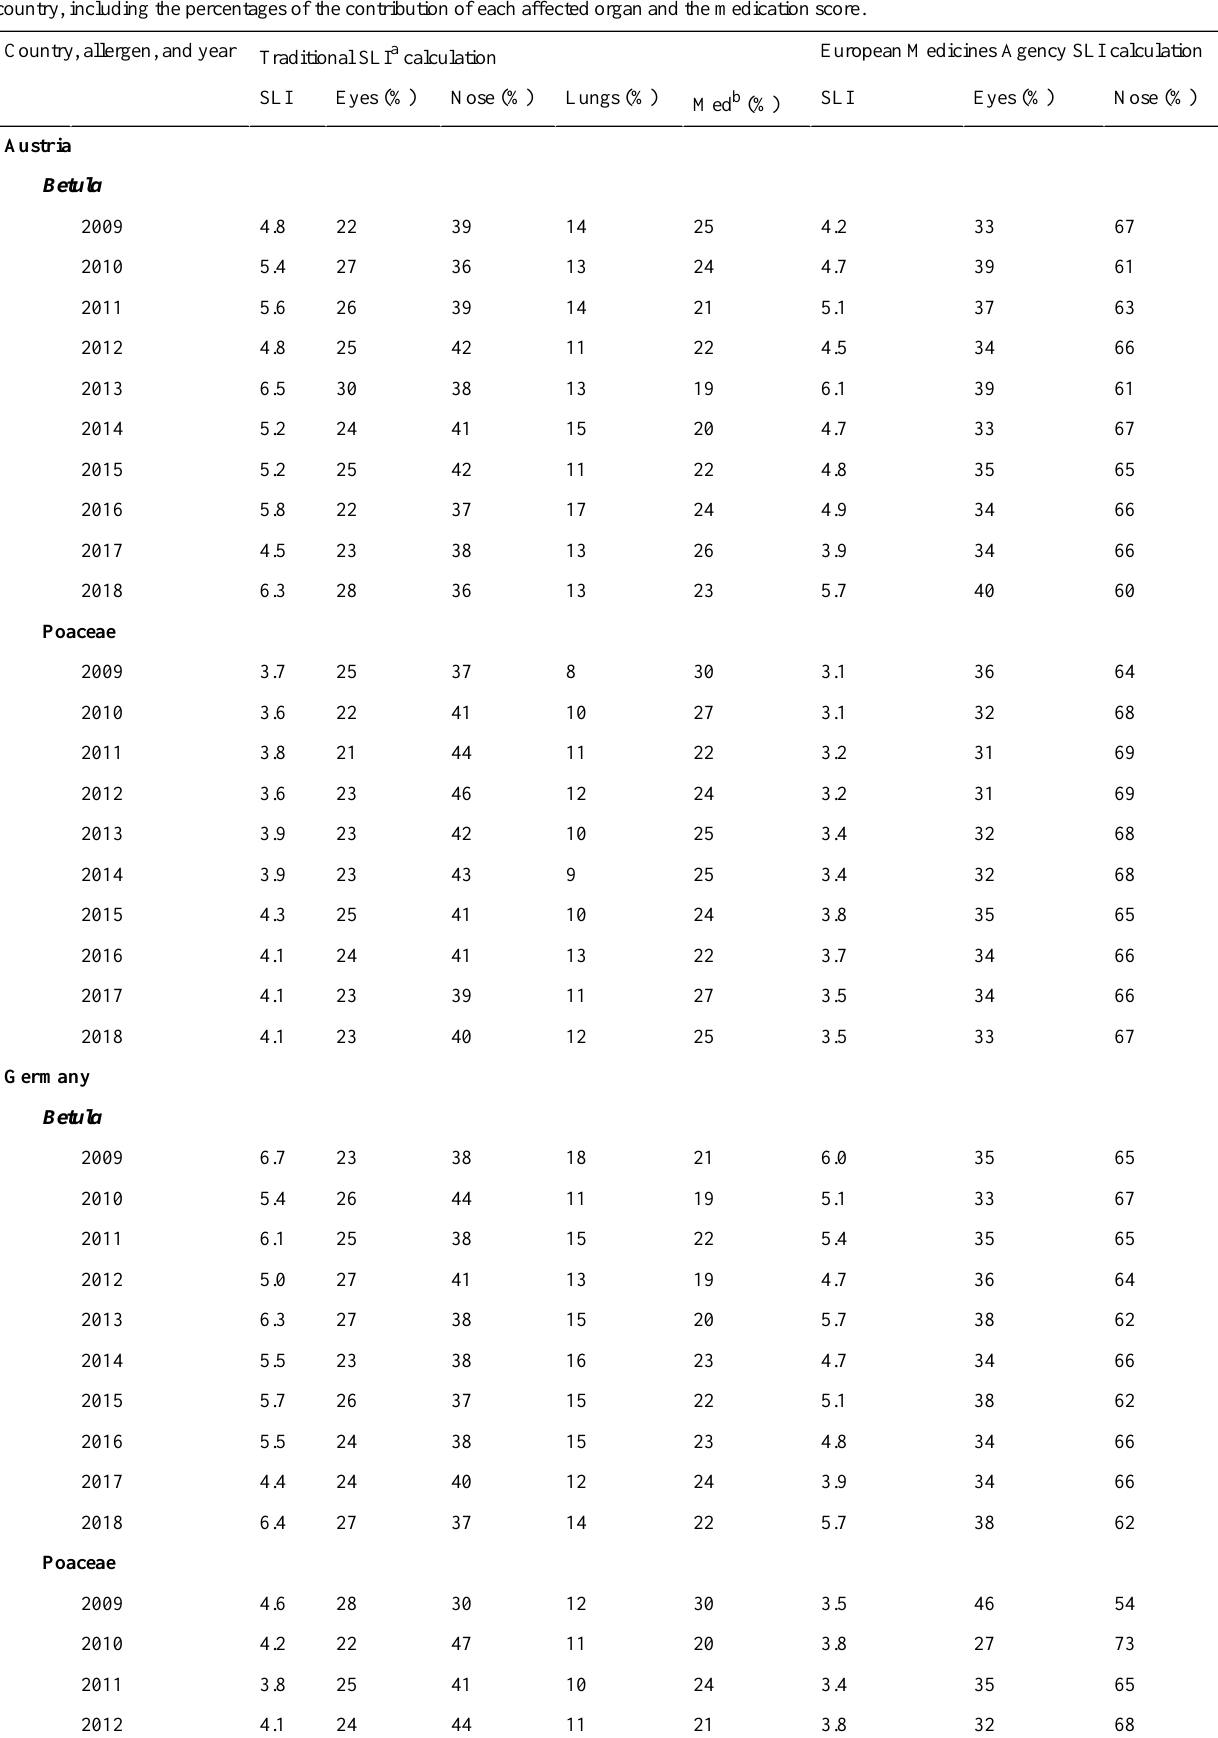
Table 2. Results of the symptom load index calculations (traditional and European Medicines Agency symptom load index) per year, season, and country, including the percentages of the contribution of each affected organ and the medication score.